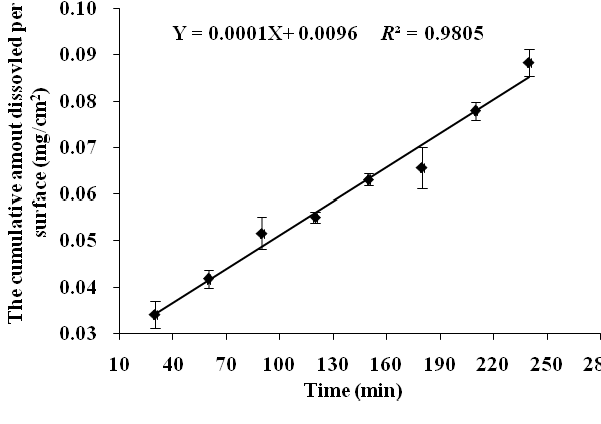
Figure 2. Intrinsic dissolution rate (IDR) of NCE in 0.1 mol/mL phosphate buffer (pH =